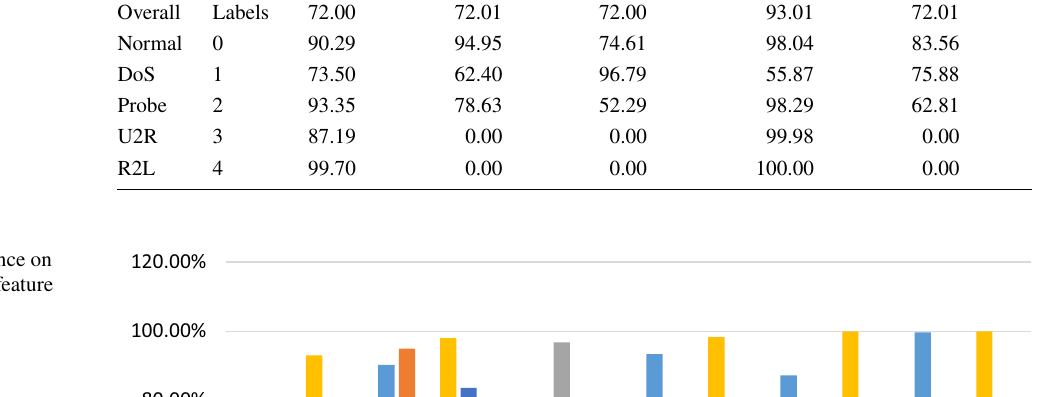
Table 11 Evaluation metrics before feature selection of the random forest